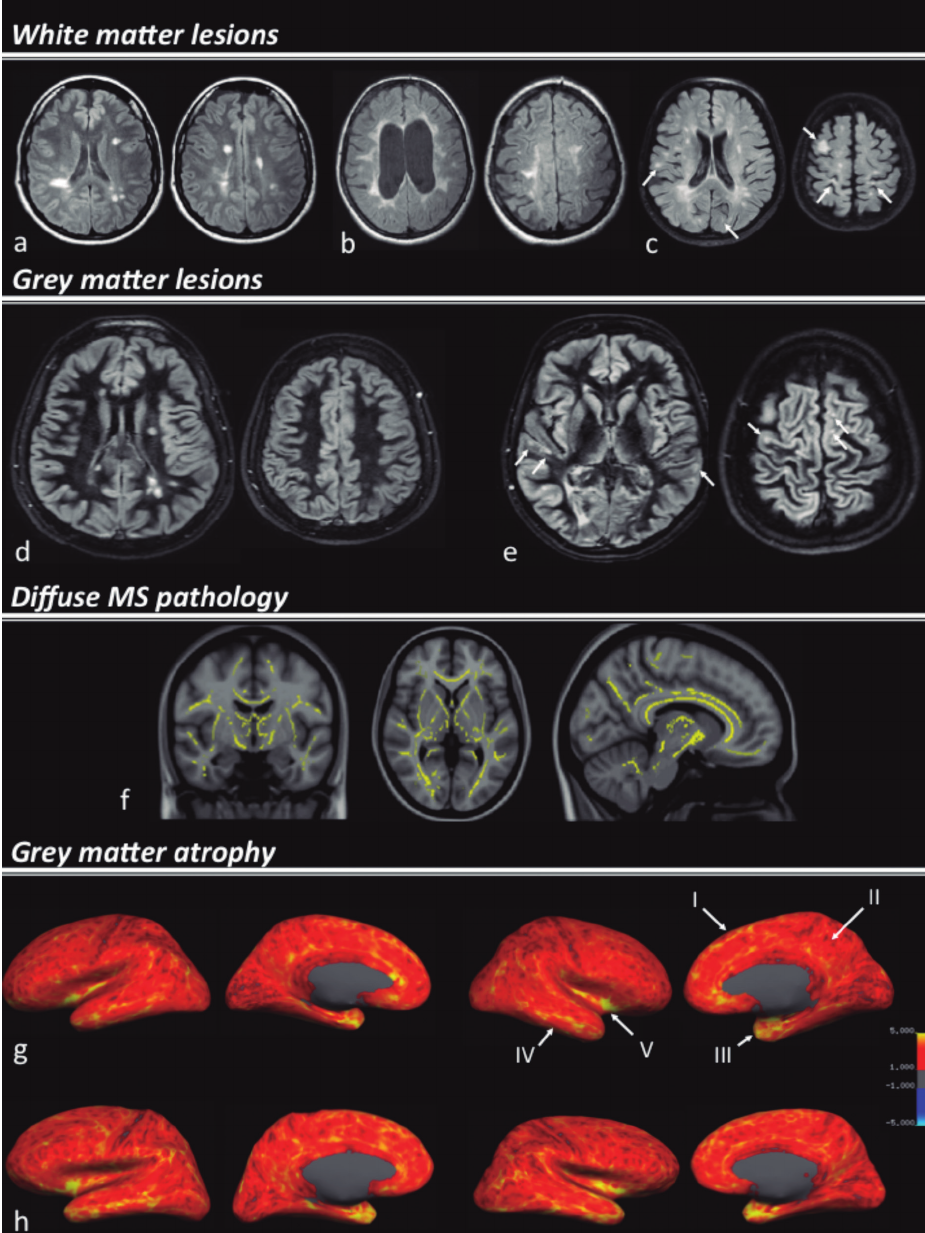
Figure 1. MRI metrics associated to brain damage and MS-related cognitive impairment. Examples of the multiple facets of MS pathology, white matter [A, B and C), grey matter lesions [D and E], diffuse MS pathology [F] and cortical grey matter atrophy [G and H] are demonstrated in the picture. White matter lesions are assorted in MS patients, with different distributions, according to the cognitive status. A cognitively preserved RRMS patient shows a lower lesion load, with predominance of centrally distributed WM lesions [A]; a SPMS patient [B] with mild cognitive impairment presents a higher lesion load, with confluent lesions, some of them reaching juxta-cortical locations; the more cognitively impaired subject [C], although this patient presents a lower overall lesion load than patient “b”, the image shows an increased rate of (juxta)cortical lesions. Double inversion recovery (DIR) images [D and E] are sensible to detect cortical lesions. A cognitively impaired MS patient [E] has a significant higher number of cortical lesions (white arrows) than a cognitively preserved patient [D]. Fractional anisotropy differences between cognitively impaired and cognitively preserved MS patients [F - reproduced from Hulst et al. 77 , with permission of Wolters Kluwer). The brain areas in yellow display reduced fractional anisotropy in cognitively impaired patients compared to cognitively preserved patients. Cortical thickness maps in a cognitively impaired MS patient [G] and a healthy control [H]. The brain images in the left represent the measurements in the lateral and medial surfaces of the left hemisphere; the brain images in the right represent the surfaces of the right hemisphere (the cortical thickness is represented in a red to yellow scale). The MS patient shows reduced cortical thickness in several associa- tive cortical areas in both hemispheres, compared to the healthy subject, remarkably in the superior frontal gyrus (I), posterior cingulate (II), temporal pole (III), temporal lobe (IV) and insula